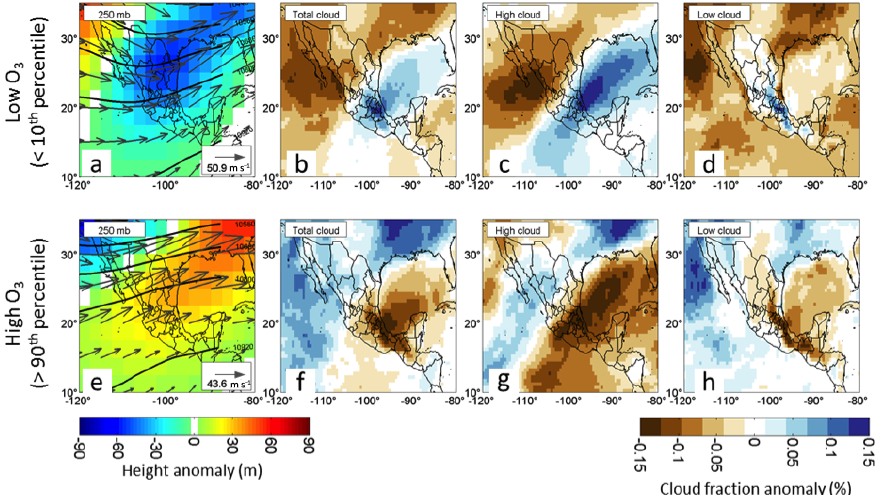
Figure 5. (a) Height (contoured, in m), height anomalies (shaded, in m), and mean winds (vectors) at 250hPa for winter (DJF) days with standard anomalies of afternoon (12:00 to 16:00LT) surface ozone at the five observing stations (Fig. 1) below the 10th percentile. (b– d) Anomalies (in %) of total cloud fraction, high cloud fraction, and low cloud fraction, respectively, for the same winter days with standard anomalies of afternoon surface ozone concentrations below the 10th percentile. (e–h) Same as in panels (a–d) , but for winter days with mean afternoon surface ozone concentrations above the 90th percentile. Percentile calculations based on hourly observations from 1986–2014. Height, wind, and cloud fraction data from ERA-Interim; ozone concentrations from RAMA stations.